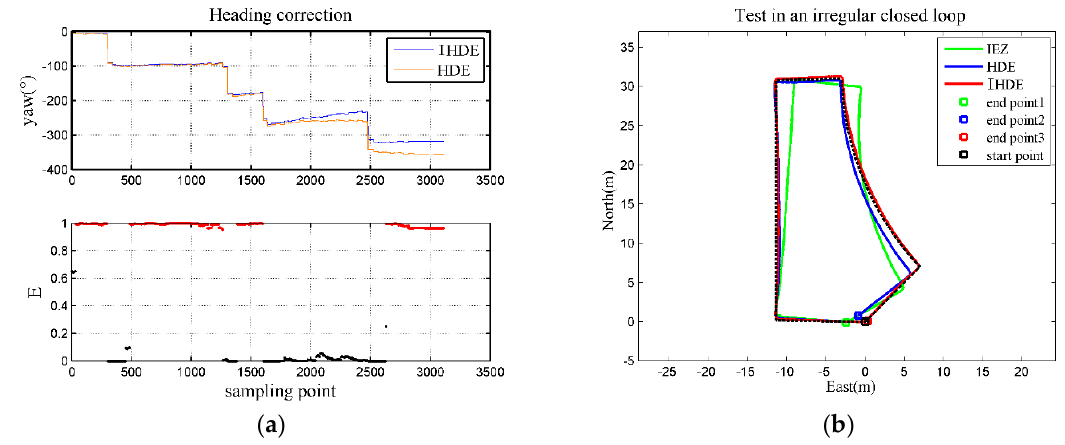
Figure 7. ( a ) Heading correction with IHDE; ( b ) estimated trajectories for Test 2.